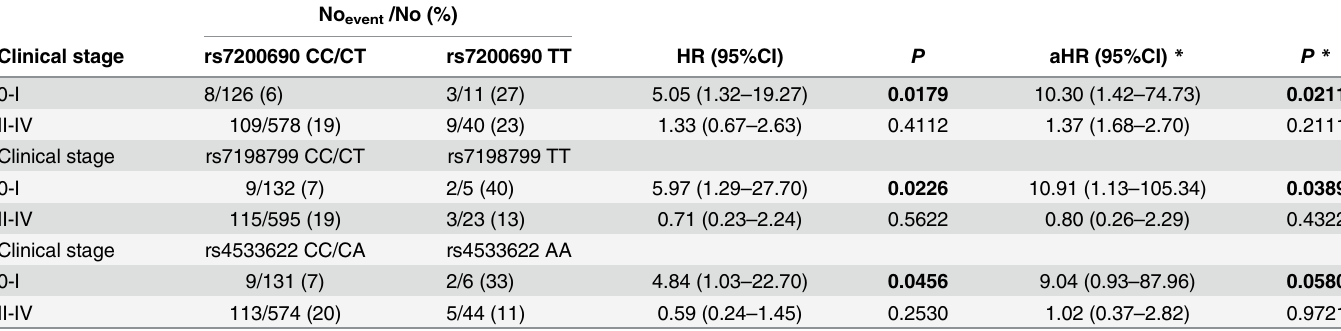
Table 7. Stratified event-free survival analysis of rs rs7200690, rs7198799 in CDH1 and rs4533622 in CTNNB1 by clinical